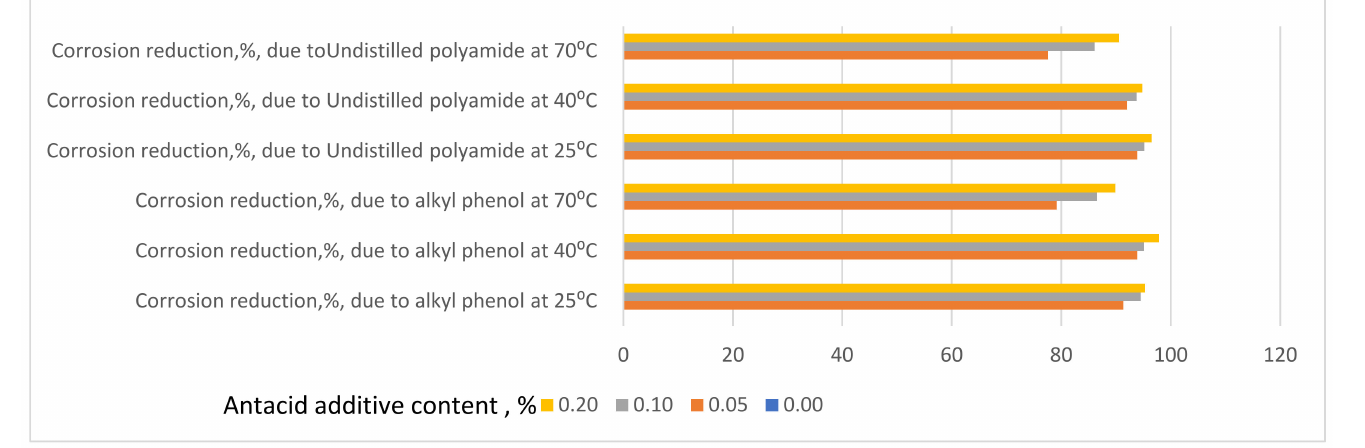
Figure 3. Effect of an additive on corrosion